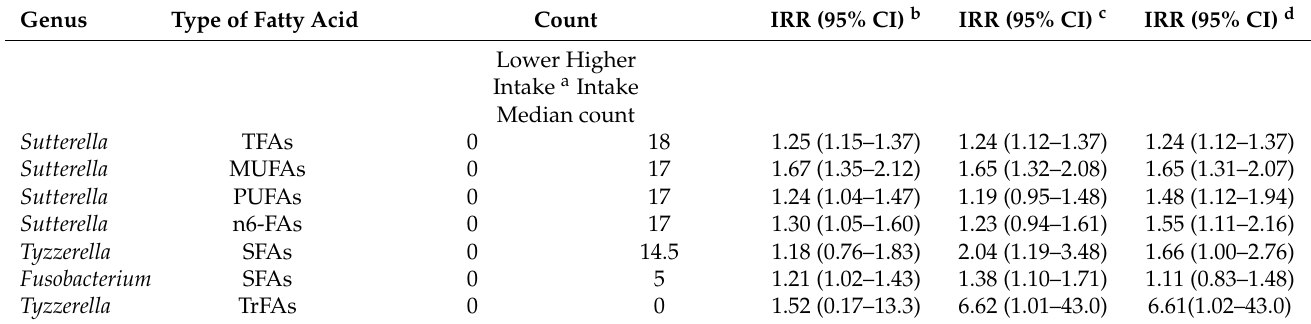
Table 4. The incidence rate ratio (IRR) of having non-zero bacterial count by fatty acid intake.